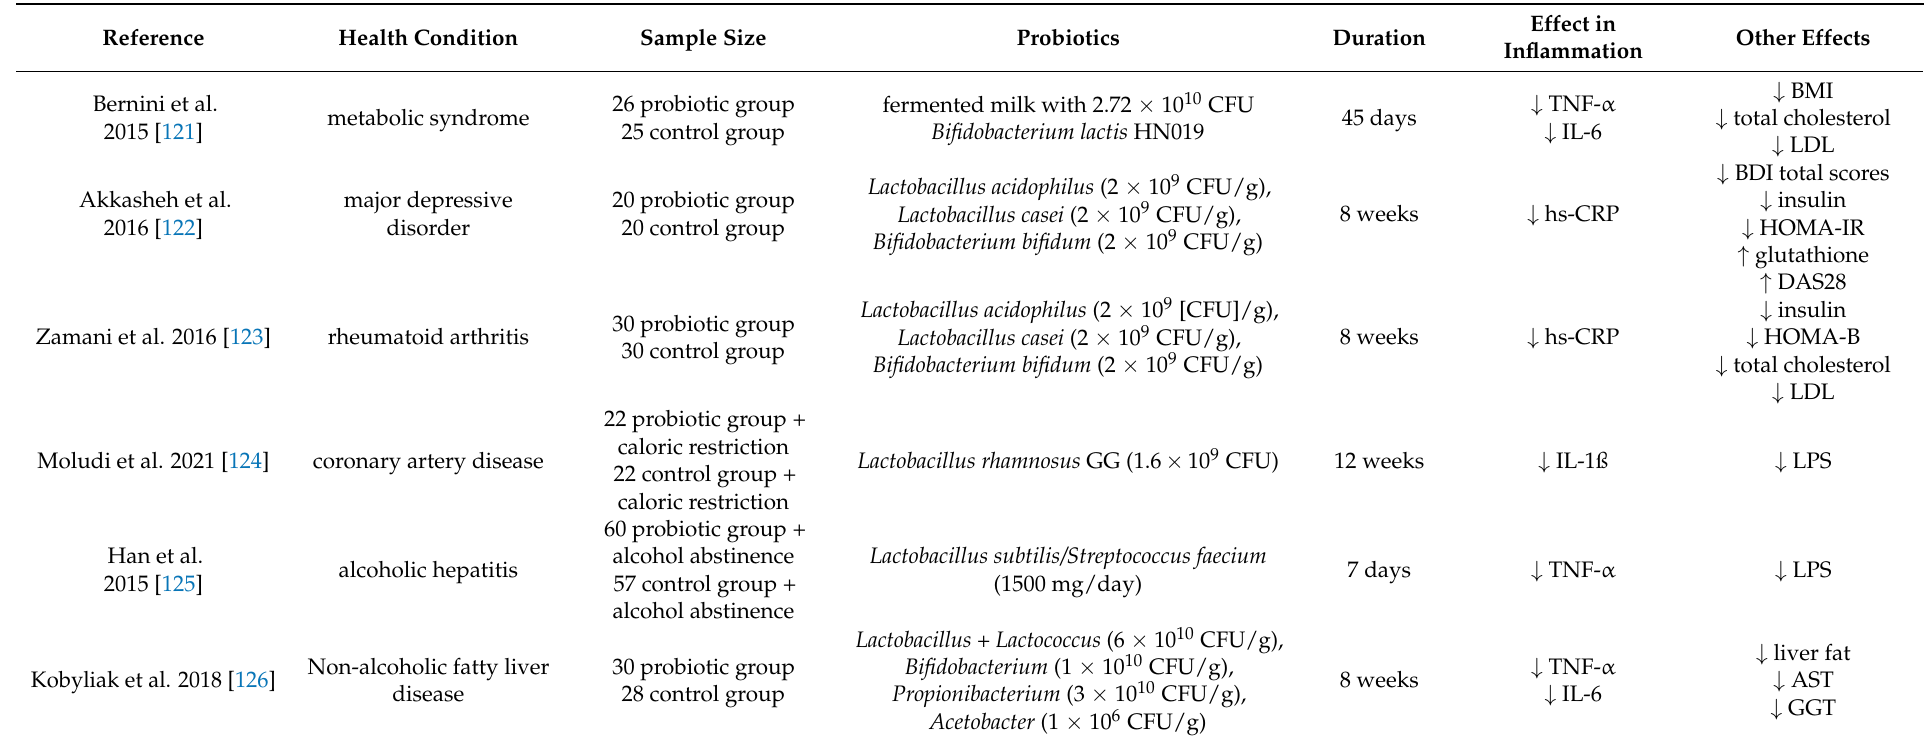
Table 1. Literature review on probiotics’ effects in various health